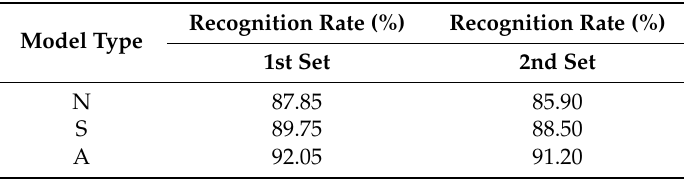
Table 3. Recognition results.